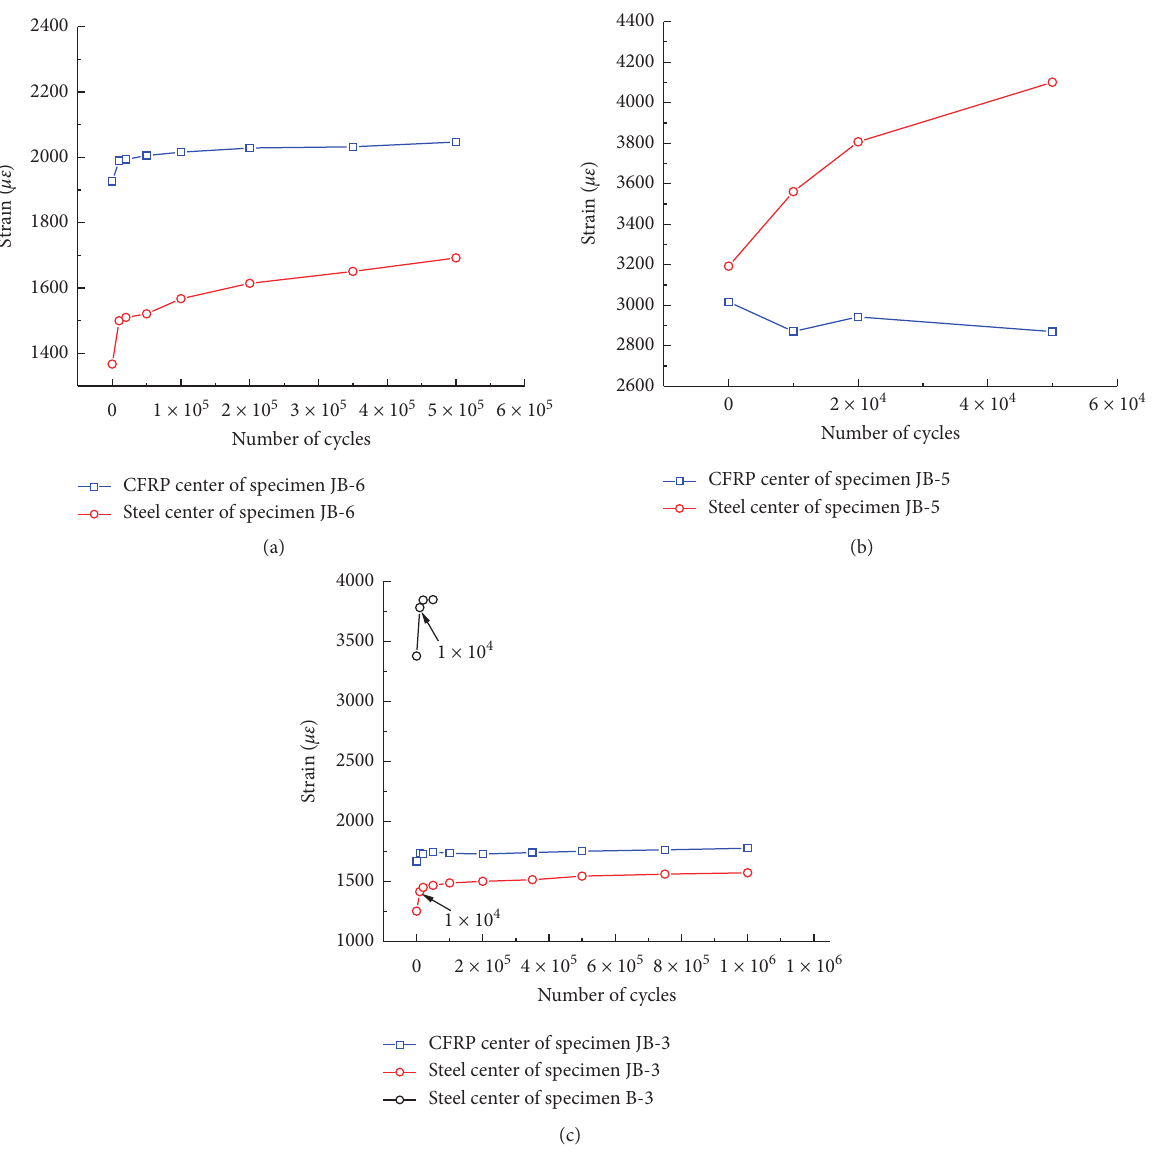
Figure 8: Curves of CFRP strain and steel versus the number of cycles. (a) P